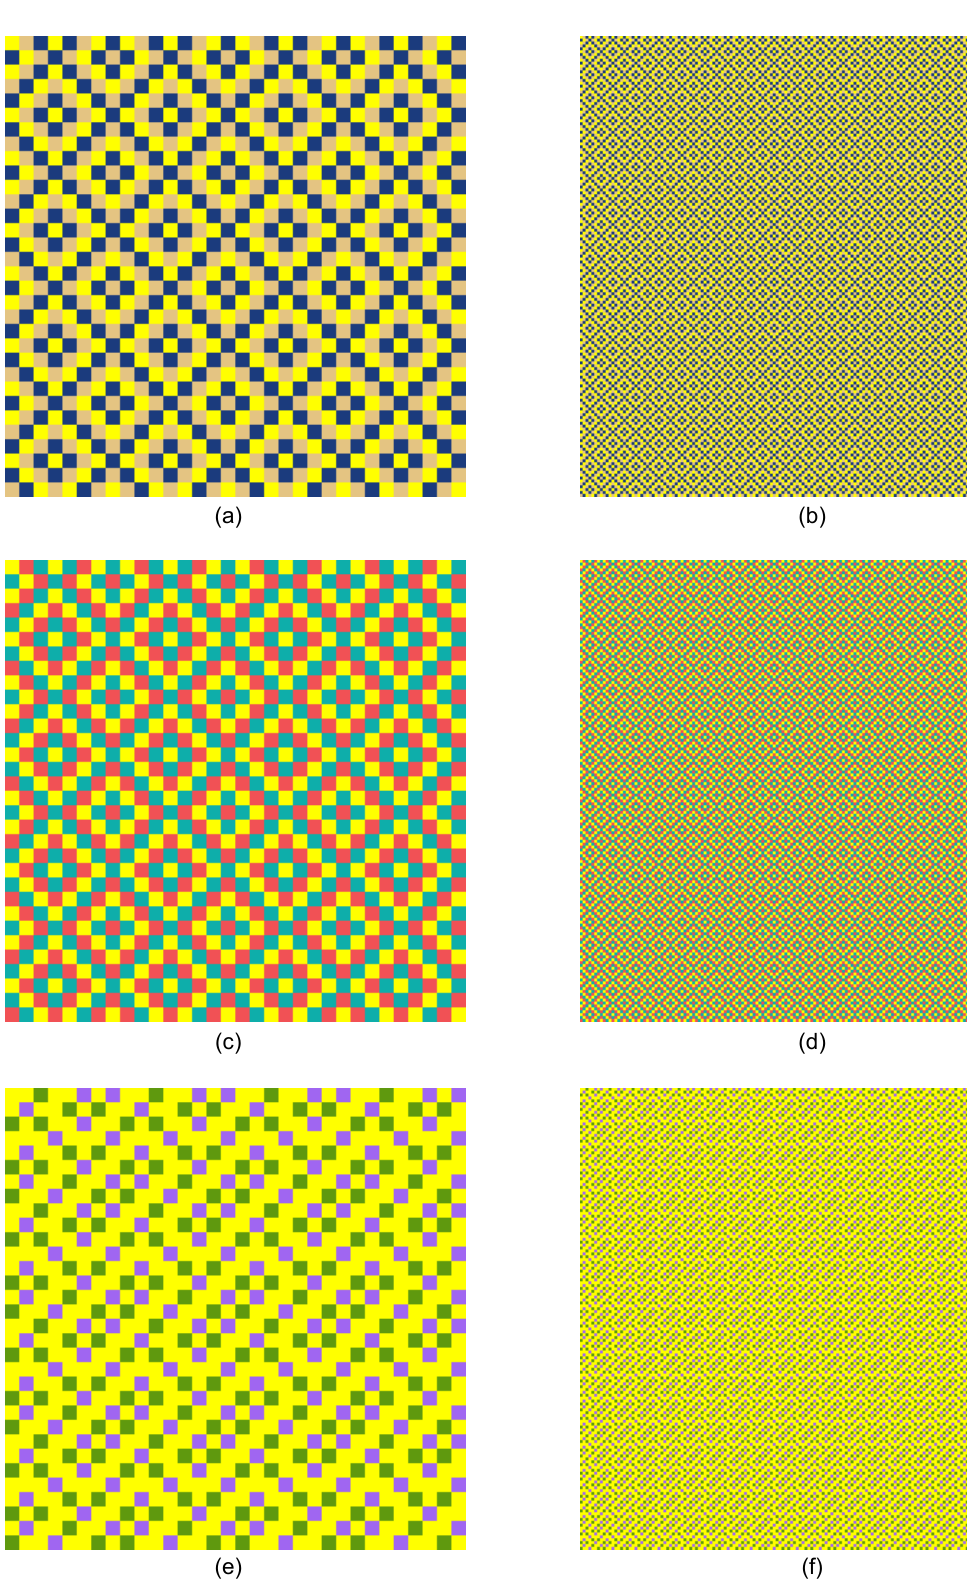
Figure 4. Illustrations of color patterns: ( a ) pattern-1 , ( b ) pattern-2 , ( c ) pattern-3 , ( d ) pattern-4 , ( e ) pattern-5 , ( f ) pattern-6.